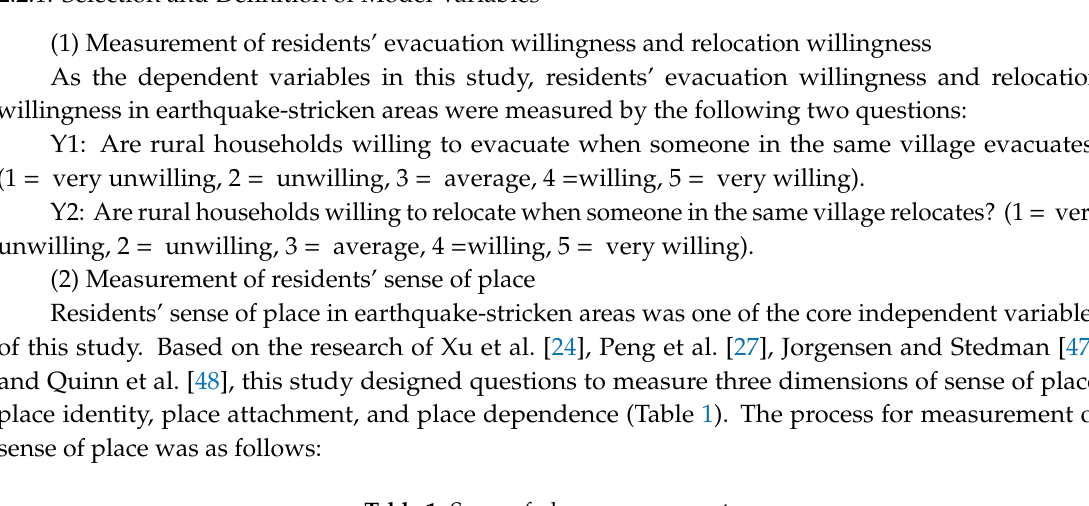
Table 1. Sense of place